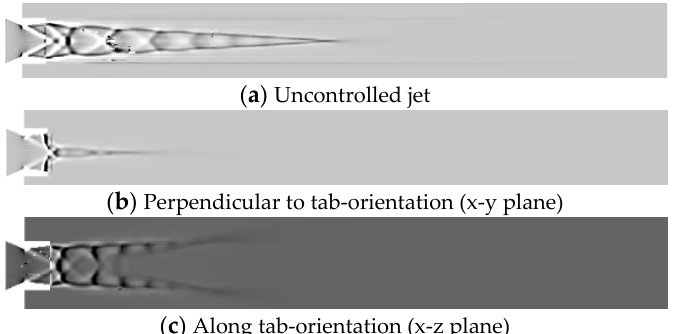
Figure 29. Schlieren views of uncontrolled and controlled jets at NPR 4 (underexpansion).